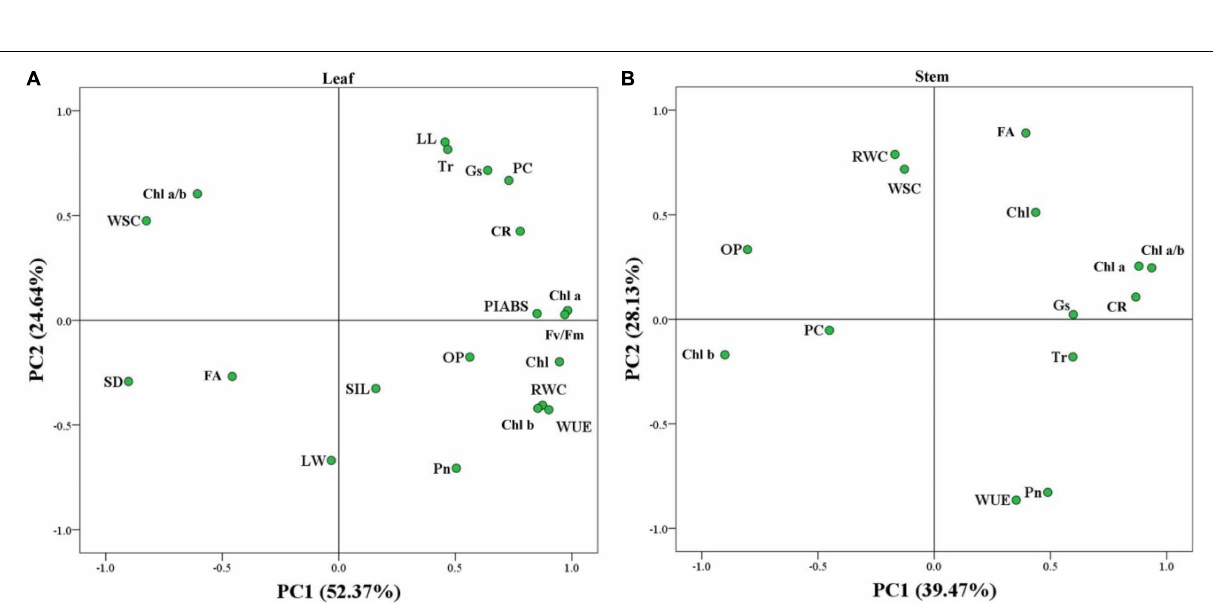
Frontiers in Plant Science |